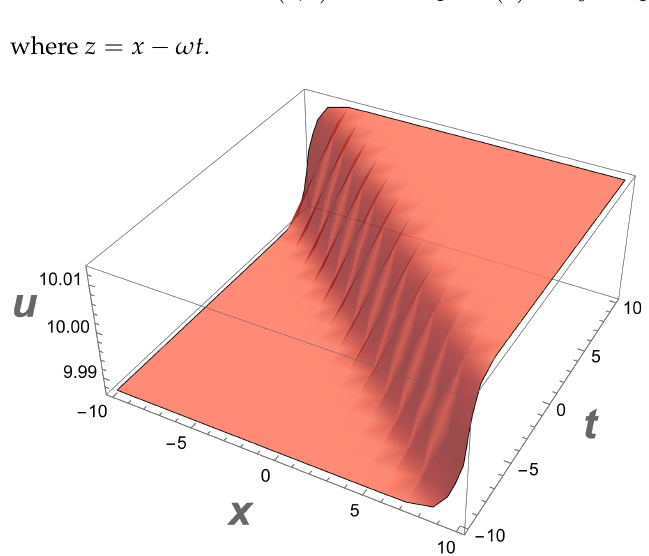
Figure 1. Evolution of the solution of (20) for case